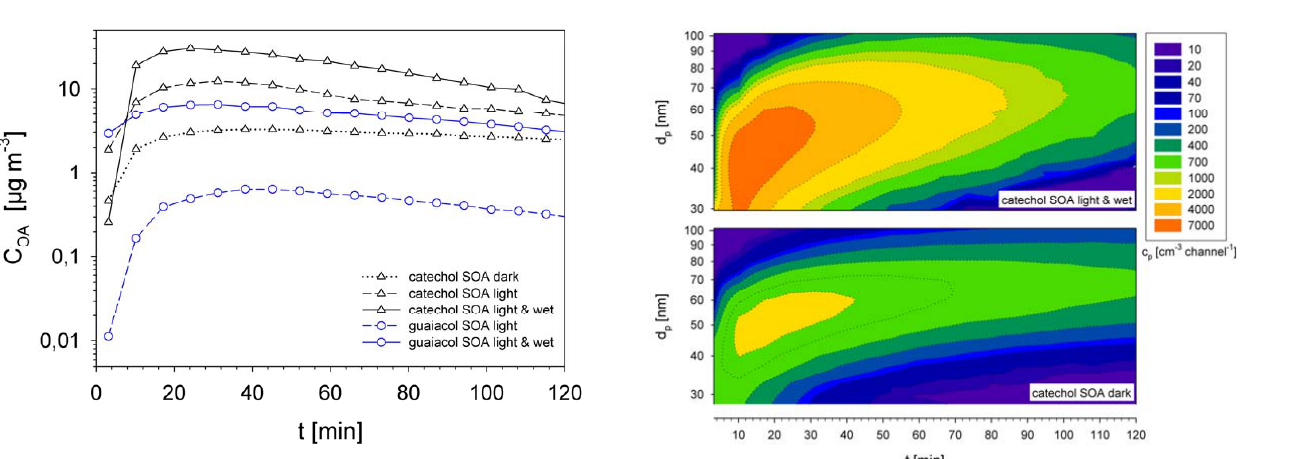
Fig. 4. Change of aerosol size distribution as a function of time: The formed particles reach final mean diameters of 65 nm (dark) and 70 nm (light & wet) after 2 hours.